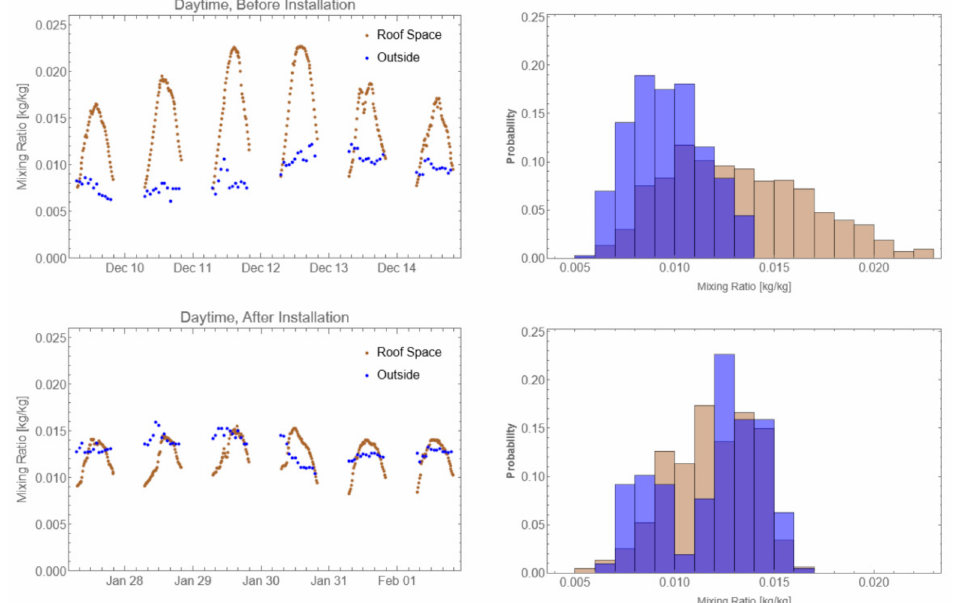
Figure 6. Probability histogram (right column) of moisture (mixing ratio [kg/kg]) distribution during daytime hours before ( top ) and after ( bottom ) installation of the solar-driven ventilator. Brown represents the roof cavity data, blue the outside climate. The graphs on the left are the corresponding time series (subset only). After the fan installation, the high moisture end with values above 0.016 kg/kg has been largely removed.